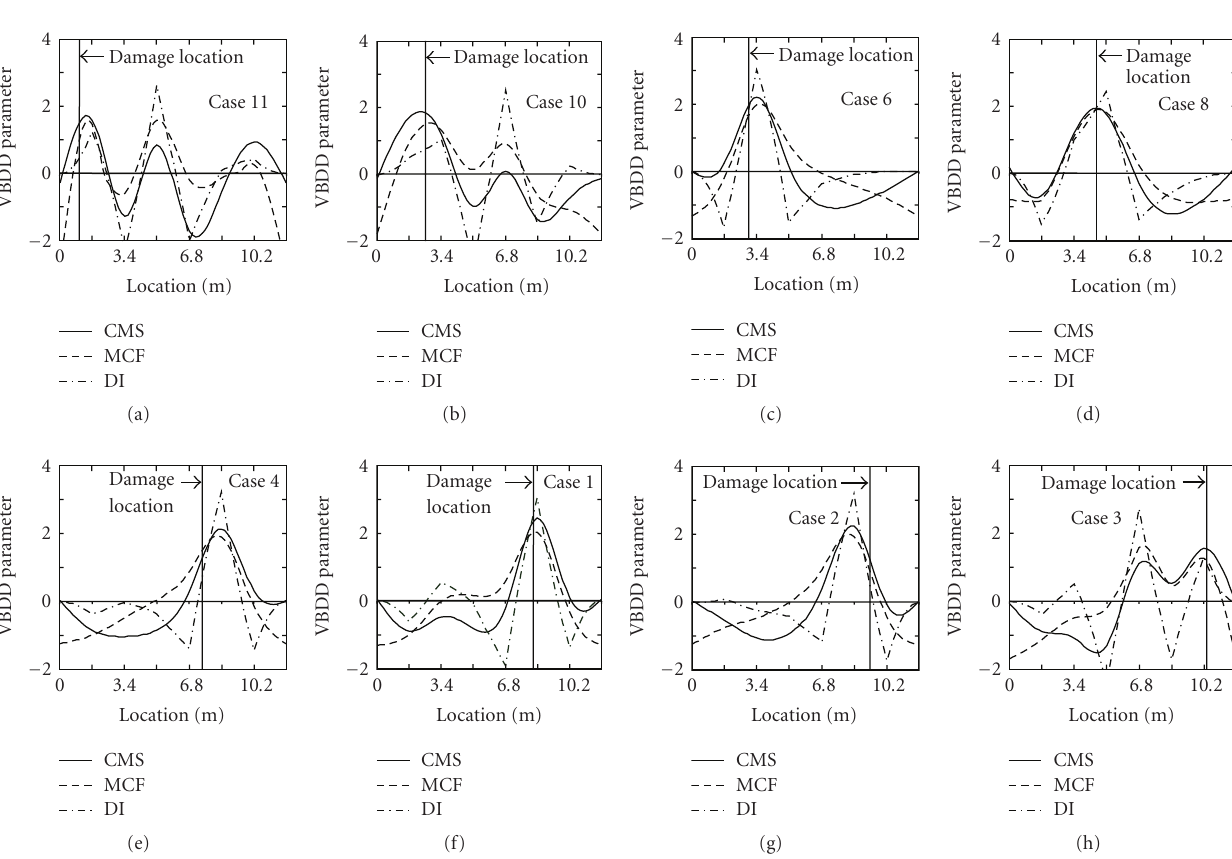
Figure 6: Normalized VBDD distributions for a sequence of experimental damage cases, with damage moving from east to west (left to right) along the